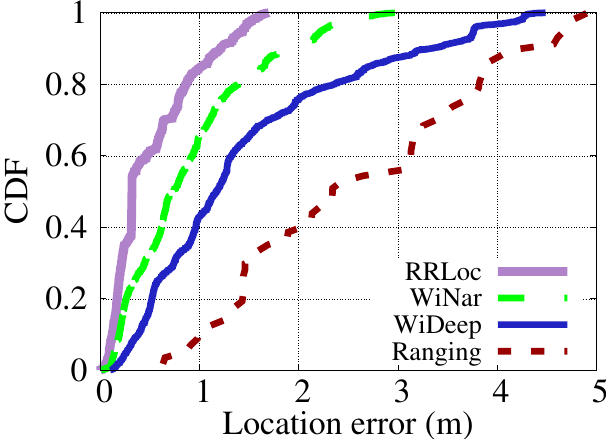
Figure 14. Comparison of CDFs of different systems in the Office testbed.